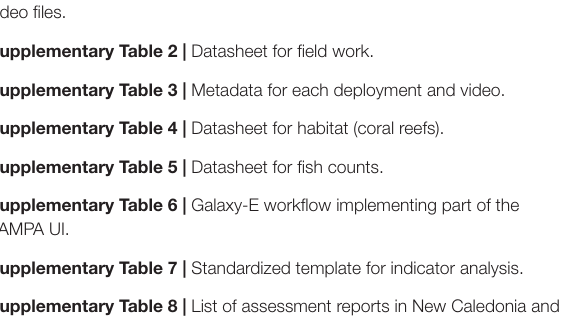
Supplementary Table 7 | Standardized template for indicator